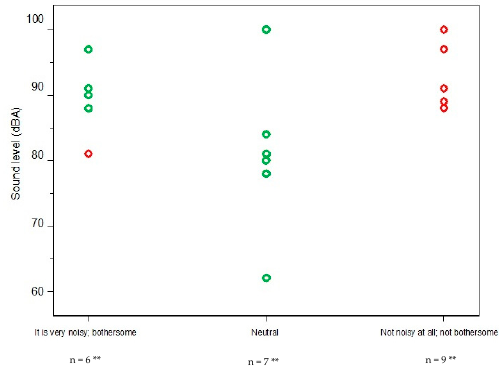
Figure 1. Plot of noise measurements * and corresponding worker perceptions where green represents convergent results and red represents divergent results.* the sound levels are the averages of the spot noise measurements from the worker’s department(s) ** some of the sound values overlap and therefore do not appear as unique points in the plot.